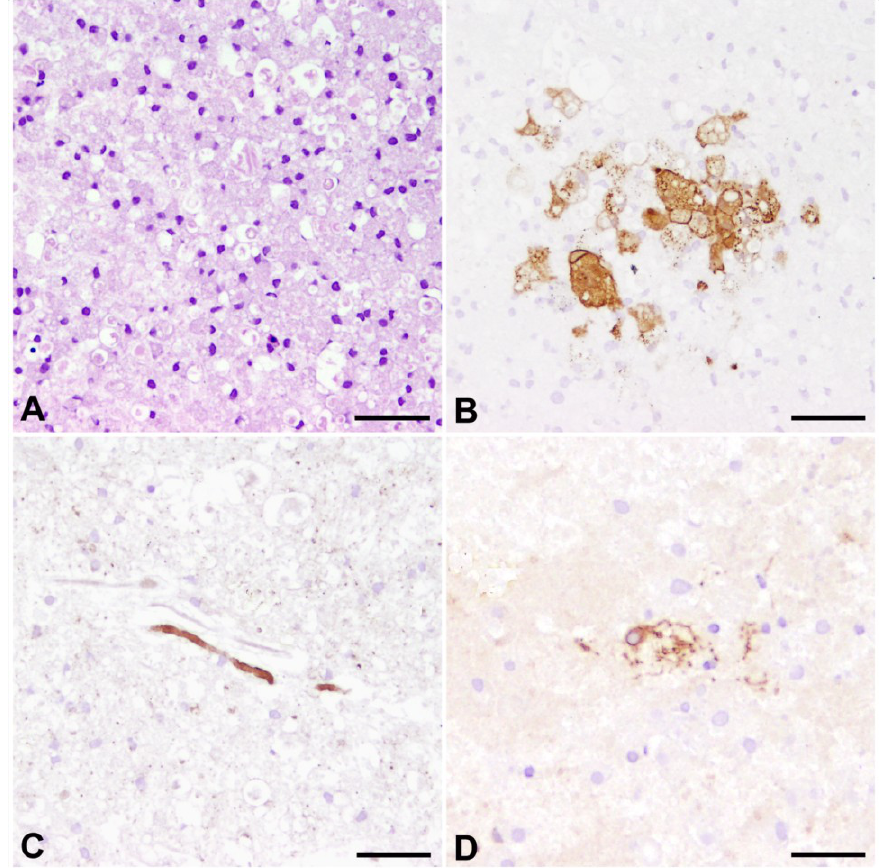
Figure 6. Organotypic slice cultures of the canine cerebellum, infected with the R252 strain of CDV and cultivated for nine days. ( A ) Hematoxylin and eosin staining reveals a remarkable response of activated, large phagocytic Gitter cells, presumably originating from resident microglia; ( B ) Immunohistochemistry for CDV shows that CDV-antigen is predominantly expressed by large, phagocytic cells reminiscent of microglia/macrophages. Whether these cells are infected by replicating virus or if they have phagocytozed viral antigen, remains to be determined in future studies; ( C ) Highly similar to axonopathy in spontaneous CDV-DL, axonal damage is characterized by enhanced expression of non-phosphorylated neurofilament. Similar axonal expression of n-NF is however also observed in non-infected slices, presumably due to mechanical transection of axons as a result of slice preparation; ( D ) p75 NTR -positive bi- to multipolar cells emerge in response to prolonged culturing, potentially indicating occurrence of pre-myelinating Schwann